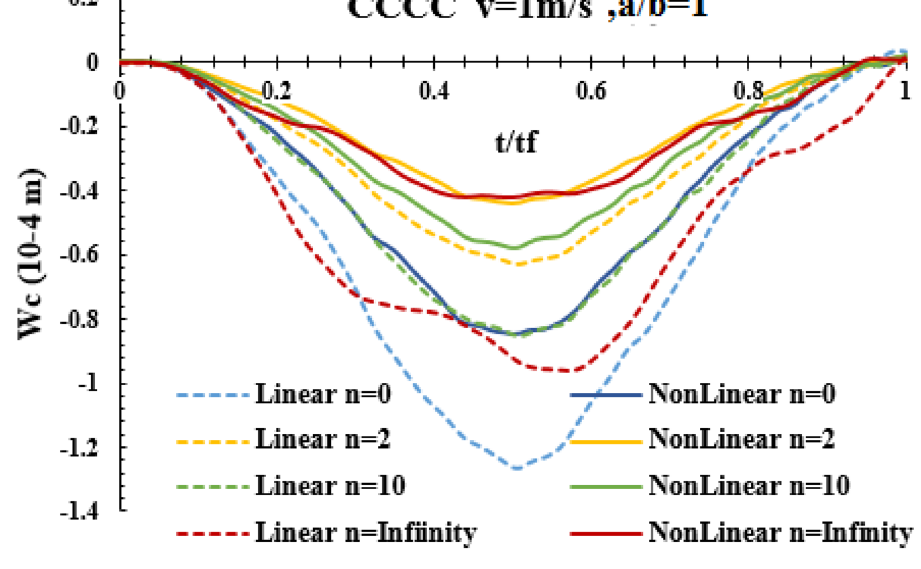
Fig. 14 The effect of magni- tude of moving load on deflec- tion history of center-point of the plate (SSSS boundary